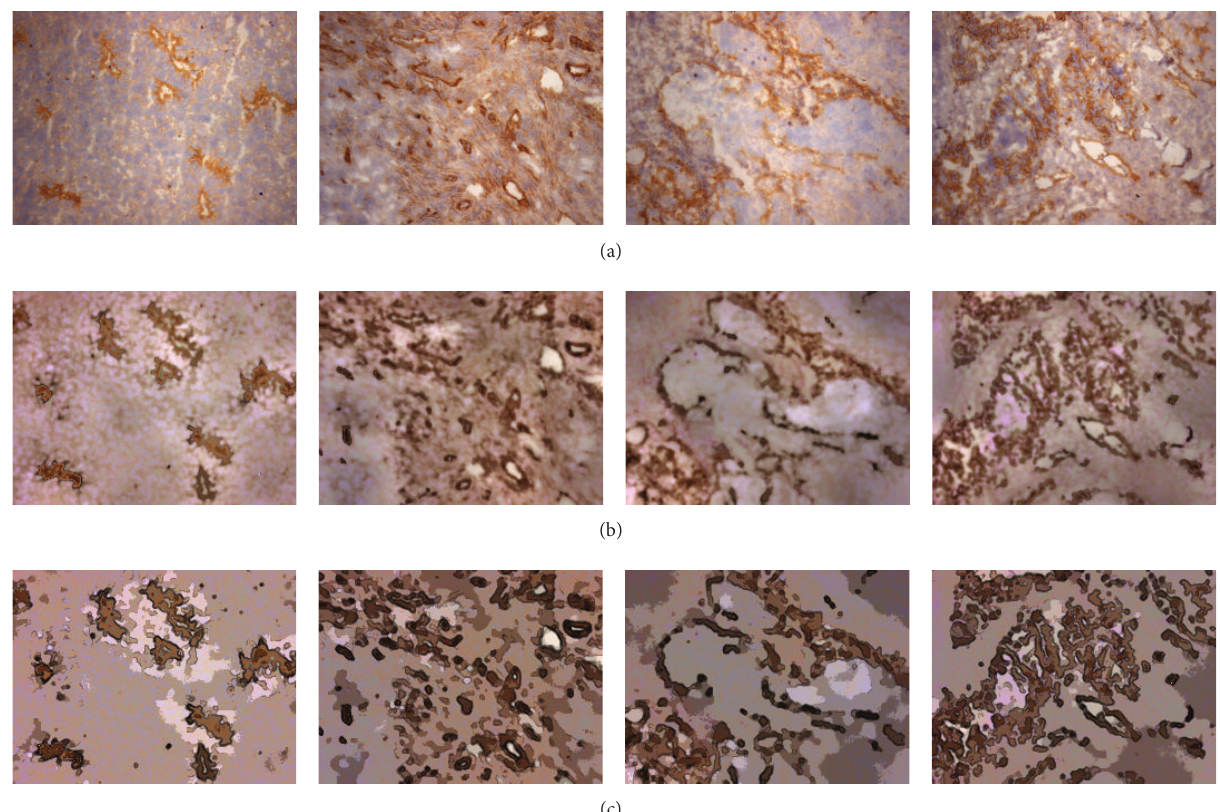
Figure 9: Abstraction results: original images (a); reconstructed images of the color layer of the original images, large-scale, and detailed layers (b); and salient blood vessel region abstraction from our proposed method (c).